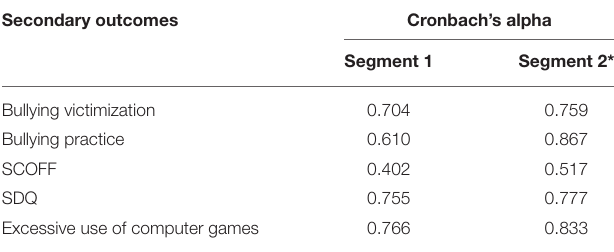
TABLE 5 | Cronbach’s alpha for the secondary outcomes of drug use by public-school students from the city of São Paulo paired in the segments 1 and 2 of the #Tamojunto2.0 drug prevention program evaluation